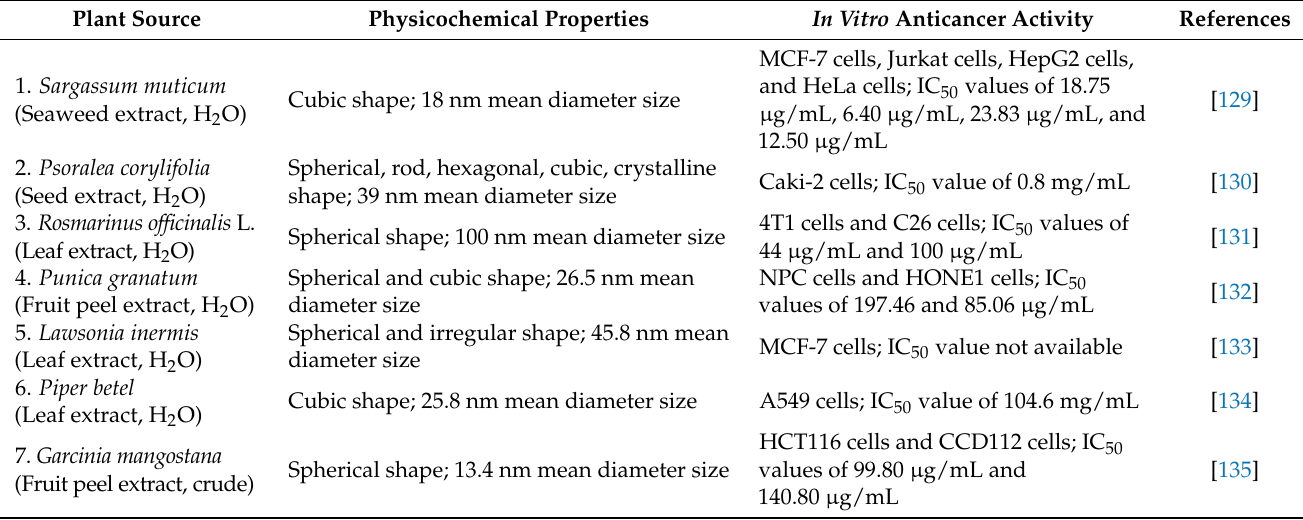
Table 3. Anticancer activity of various biosynthesized magnetic